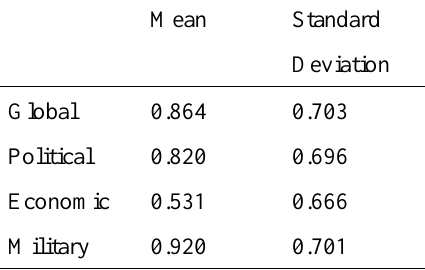
Table 3: Correlations between the globalization index and the system